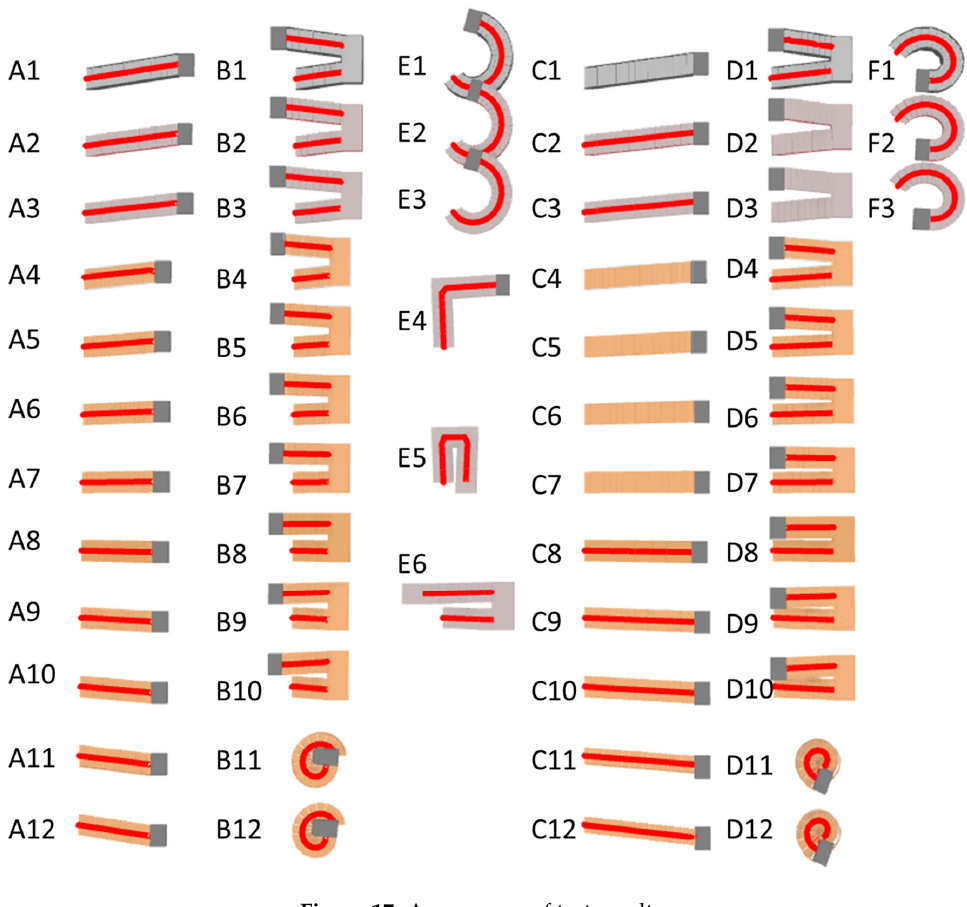
Figure 17. A summary of test results. Table 3. Summary of test